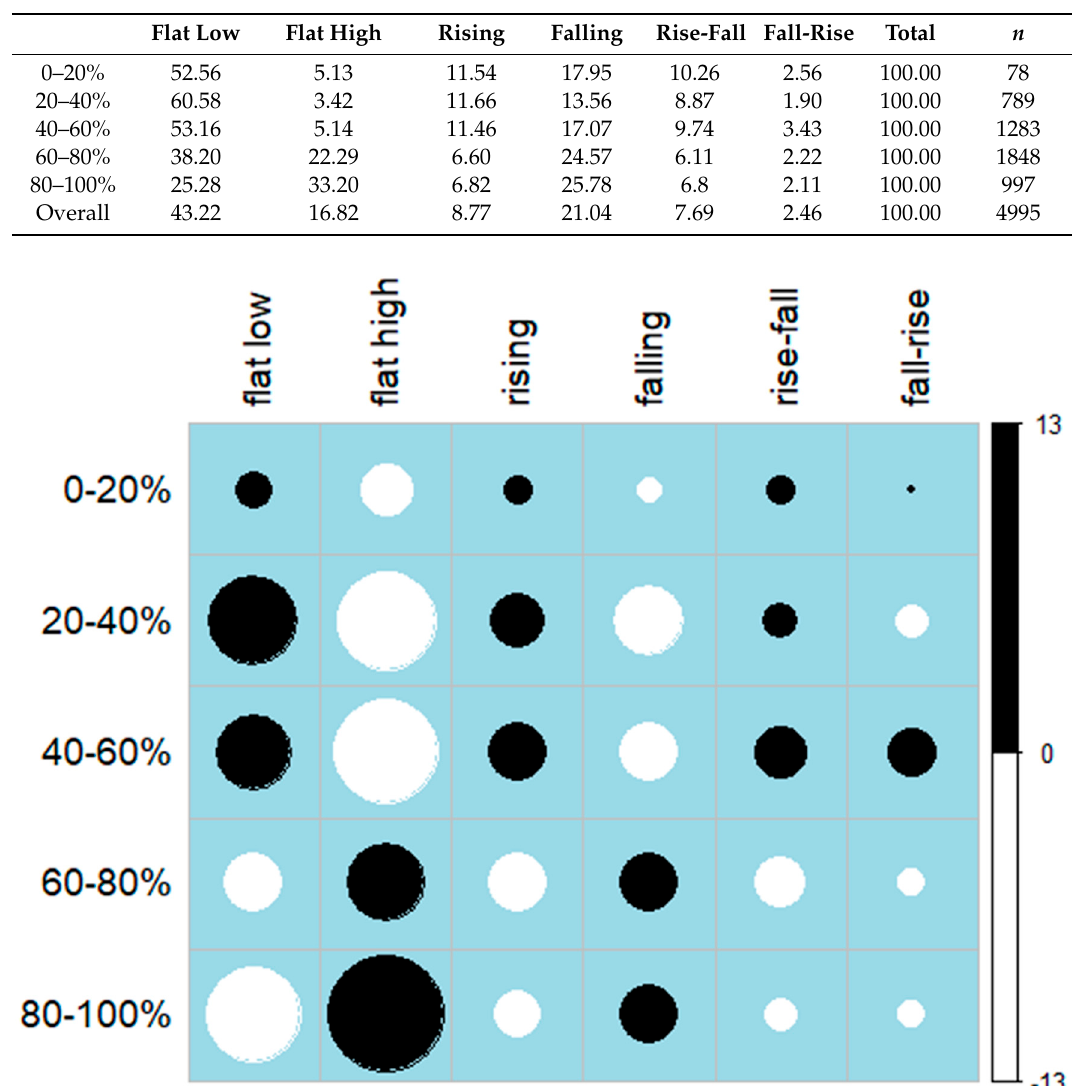
Figure 7. Correlation plot showing residuals of profile type and FVR.